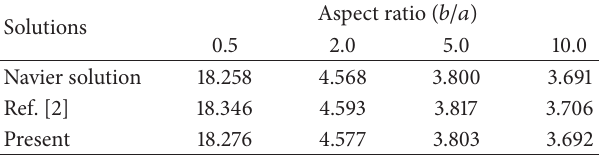
Table 4: Nondimensional fundamental frequency of simply sup- ported FGM plates with various aspect ratio ( 𝑝 = 10 ).